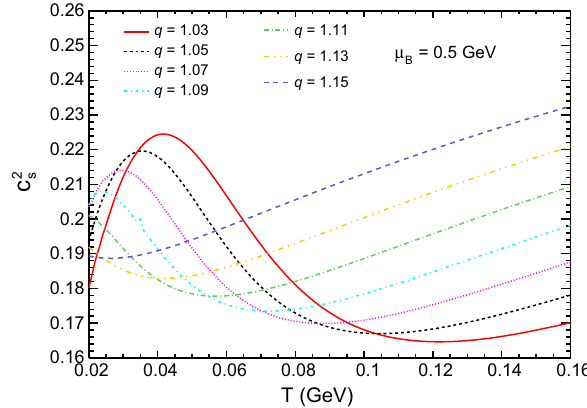
Fig. 9 Speed of sound as a function of temperature for various values of q , with μ B = 0.5 GeV